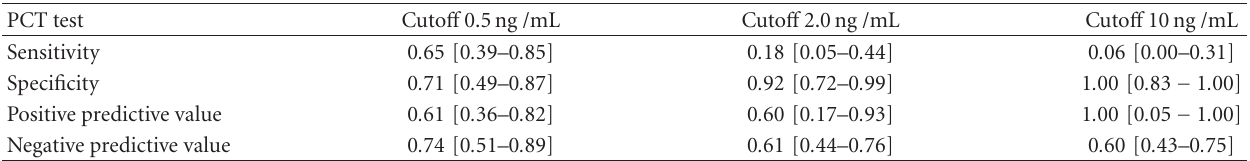
Table 3: Descriptive statistics of procalcitonin (PCT) as an admission biomarker for bacteremia in 41 travellers who had a confirmed bacterial cause of fever and a blood-culture done on admission. Data are given as proportion [95% confidence interval] .